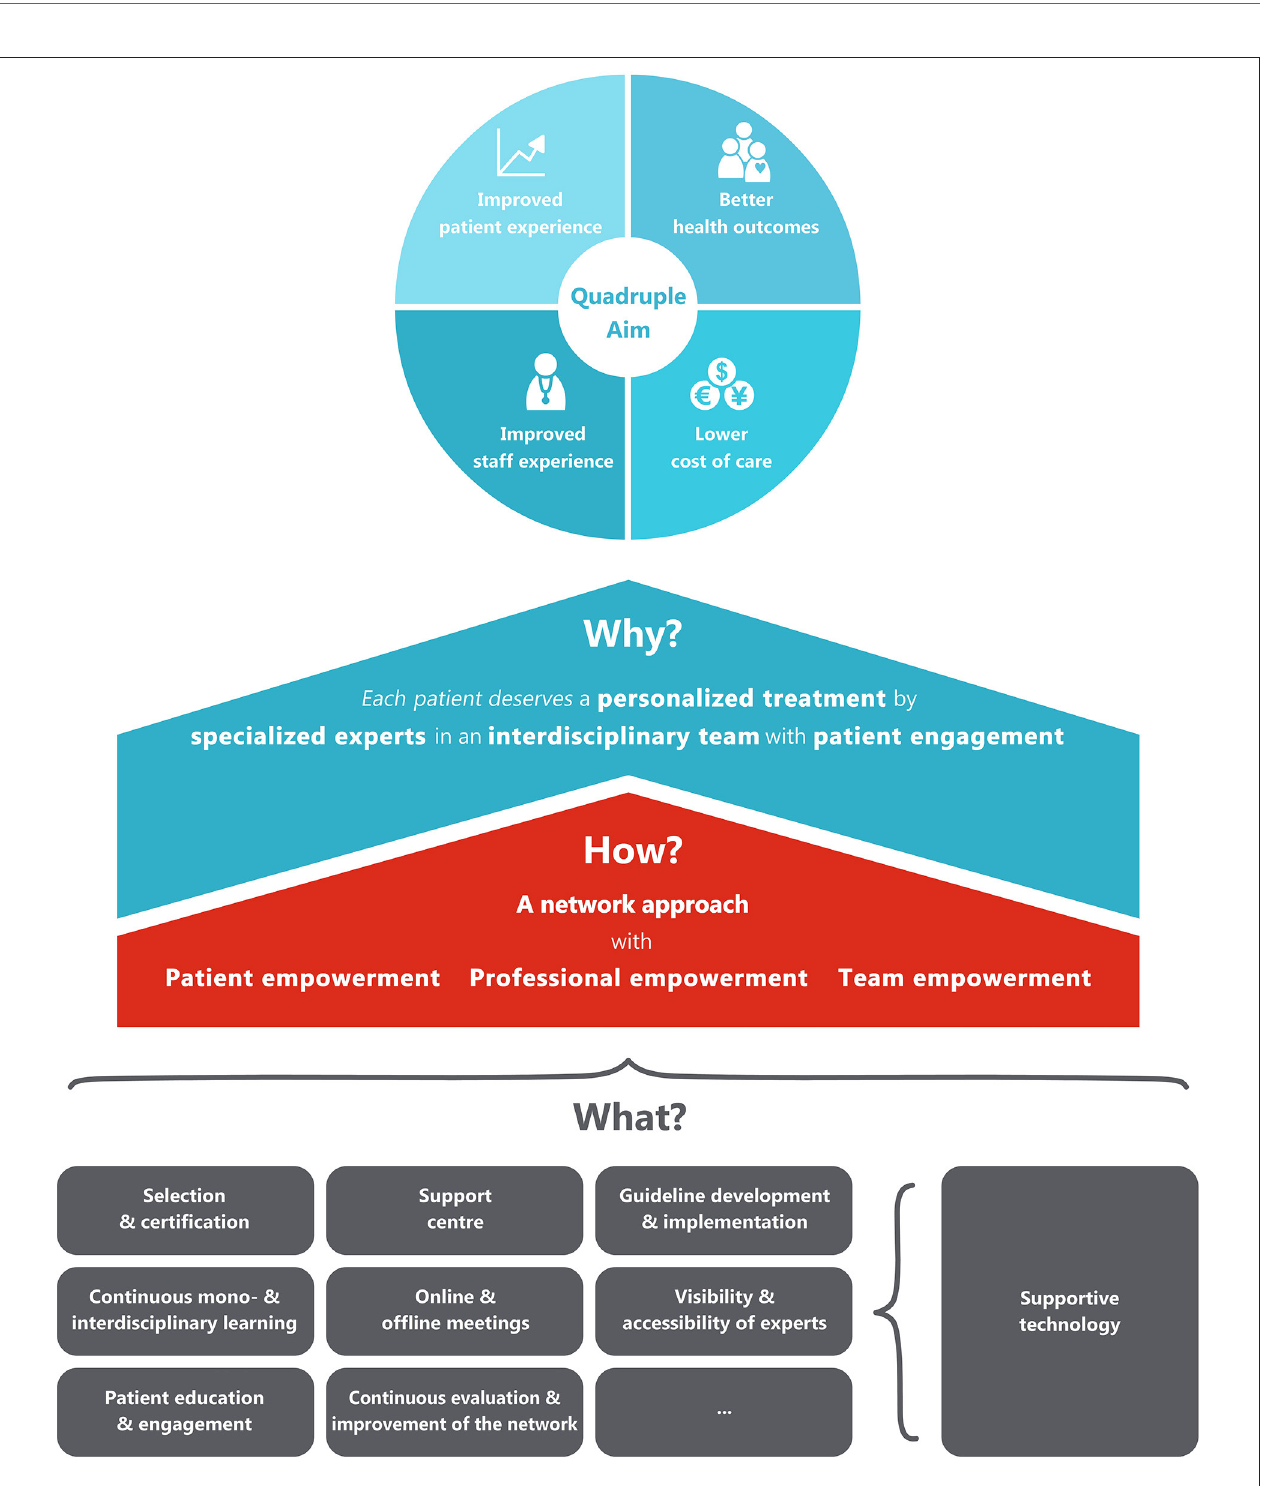
FIGURE 1 | Proposed universal model for integrated network